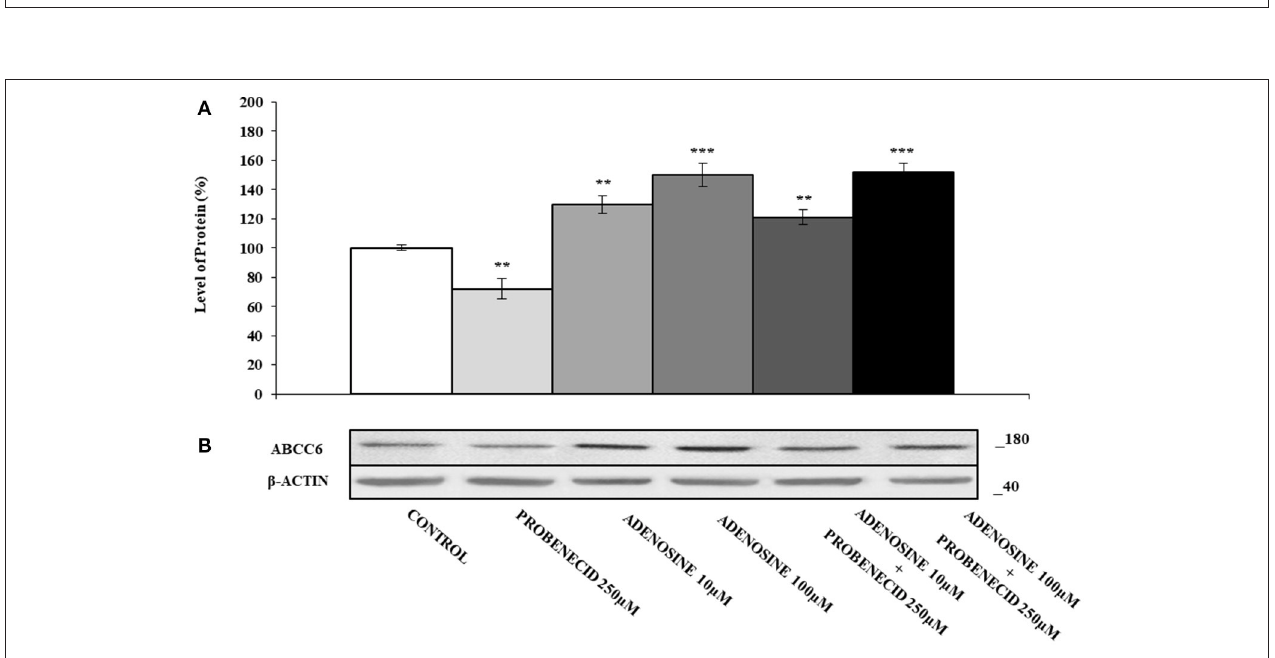
FIGURE 5 | The effects of adenosine on ABCC6 protein expression, with or without Probenecid. (A,B) Densitometric analysis and representative western blot of the ABCC6 protein in three independent experiments (means ± SD). ** p < 0.01, *** p < 0.001, Student’s t -test. β -actin was used as a loading control. All the experiments were performed treating HepG2 cells with adenosine and/or Probenecid for 48h. DMSO-treated cells were used as control.